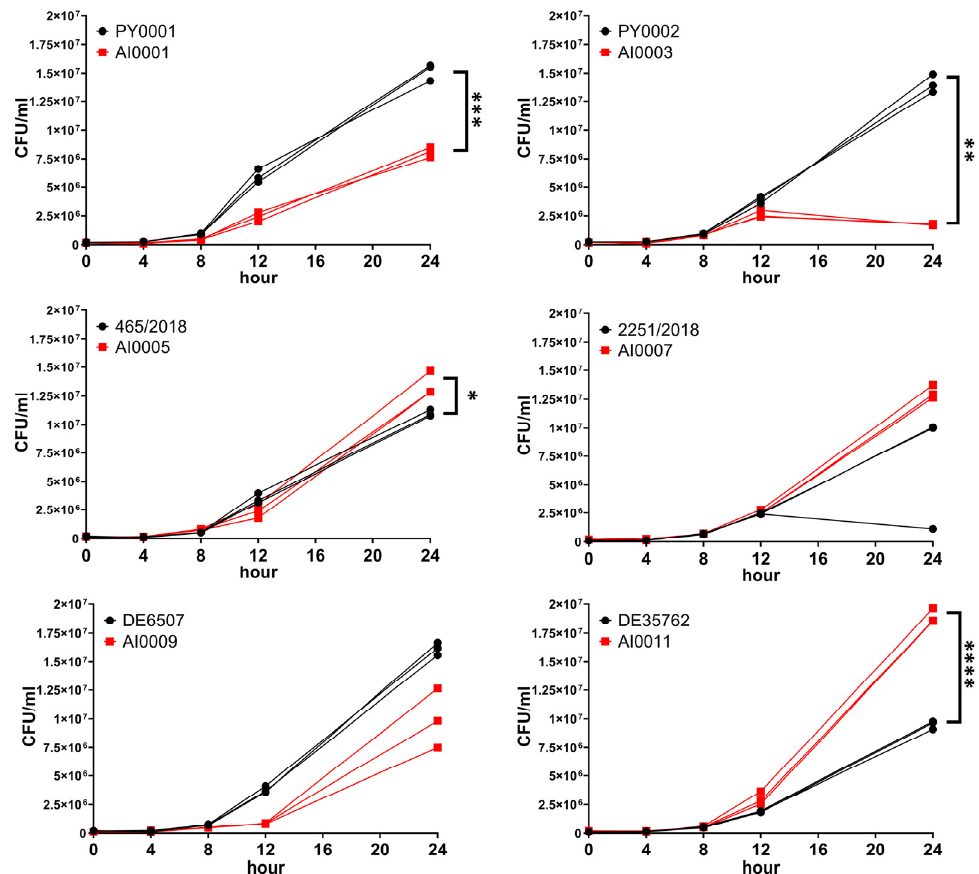
Figure 4. Comparison of growth curves of the isolates and HMX1 deletion strains in medium of 50% RPMI-1640 and 50% human serum. Individual data points for wild-type strains are indicated with black, while data for the knockout mutants are indicated with red. Data points of each replicate are connected by a line. Comparisons with significant differences are marked (*: p < 0.05; **: p < 0.01; ***: p < 0.001; ****: p < 0.0001).